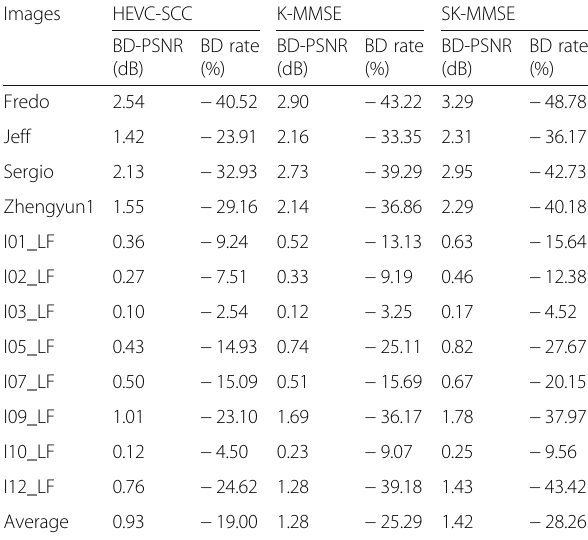
Table 3 YUV-rate-distortion gains of three coding methods over HEVC